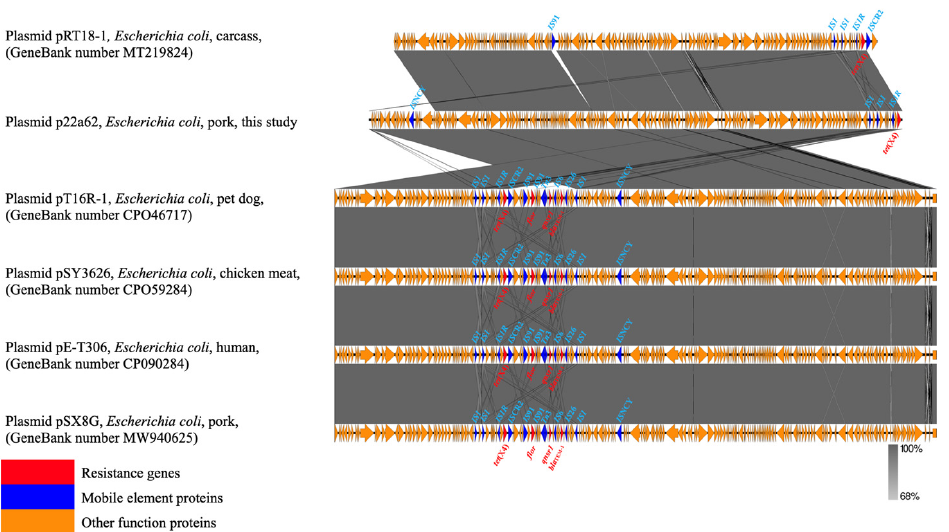
Figure 3. Comparison of the genetic context of tet (X4) with those of closely related sequences. The extent and direction of genes are shown by arrows labeled with gene names. Red arrows—resistance genes; blue arrows—mobile elements proteins; yellow arrows—other functional proteins.